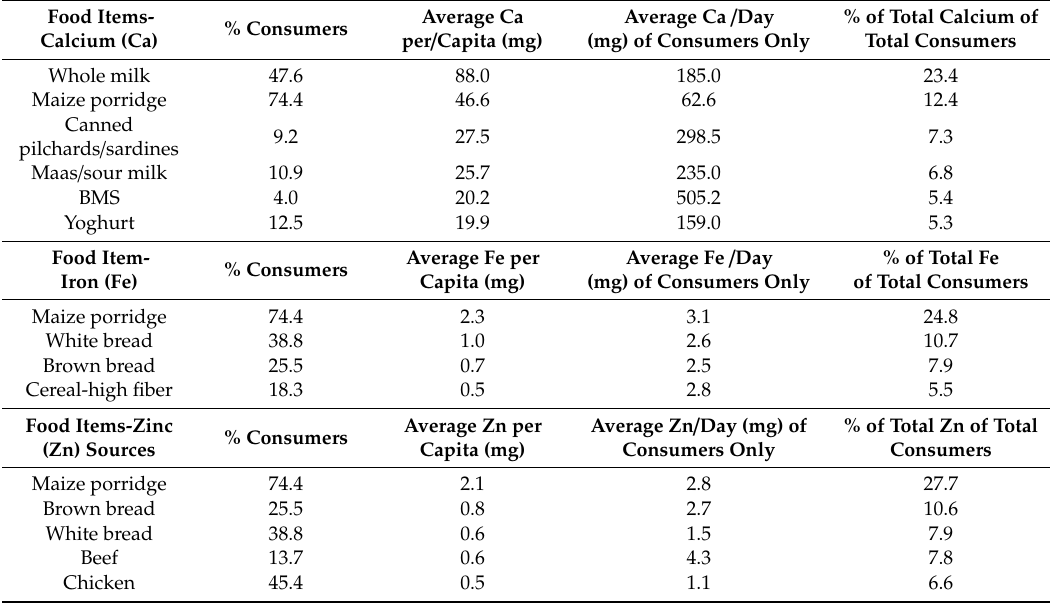
Table 5. Food items that contributed at least 5% to the total intake of calcium, iron and zinc of children aged 1 to < 10 years (N =